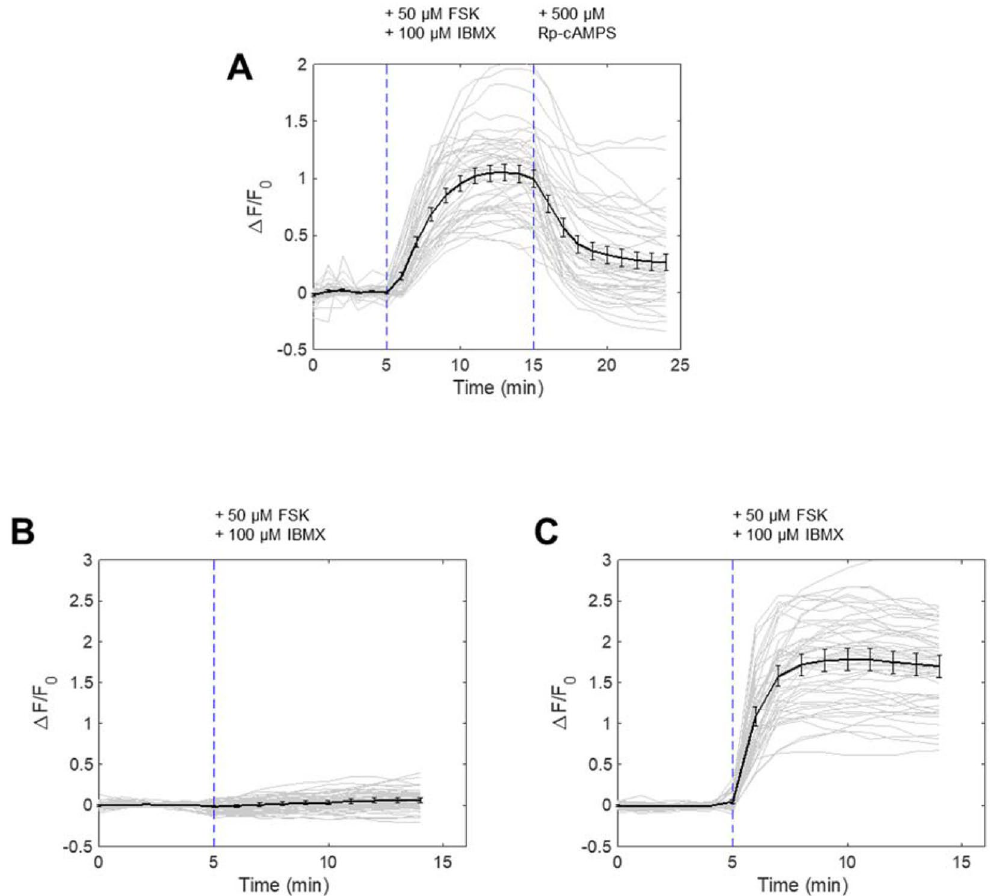
Figure 4. Specificity of PKA kinase reporter to PKA activation by pharmacological and genetic inhibition. ( A ) Nuclear-cytosol translocation of PKA kinase reporter by FSK/IBMX treatment and reversal with PKA inhibitor Rp-cAMPS (500 μ M, Santa-Cruz, Sc-24010). (N = 3 experiments, 45 cells). ( B ) Nuclear-cytosol translocation of PKA kinase reporter in cells co-expressing mCherry-PKI. (N = 3 experiments, 54 cells). ( C ) Nuclear-cytosol translocation of PKA kinase reporter in cells co-expressing mCherry. (N = 3 experiments, 51